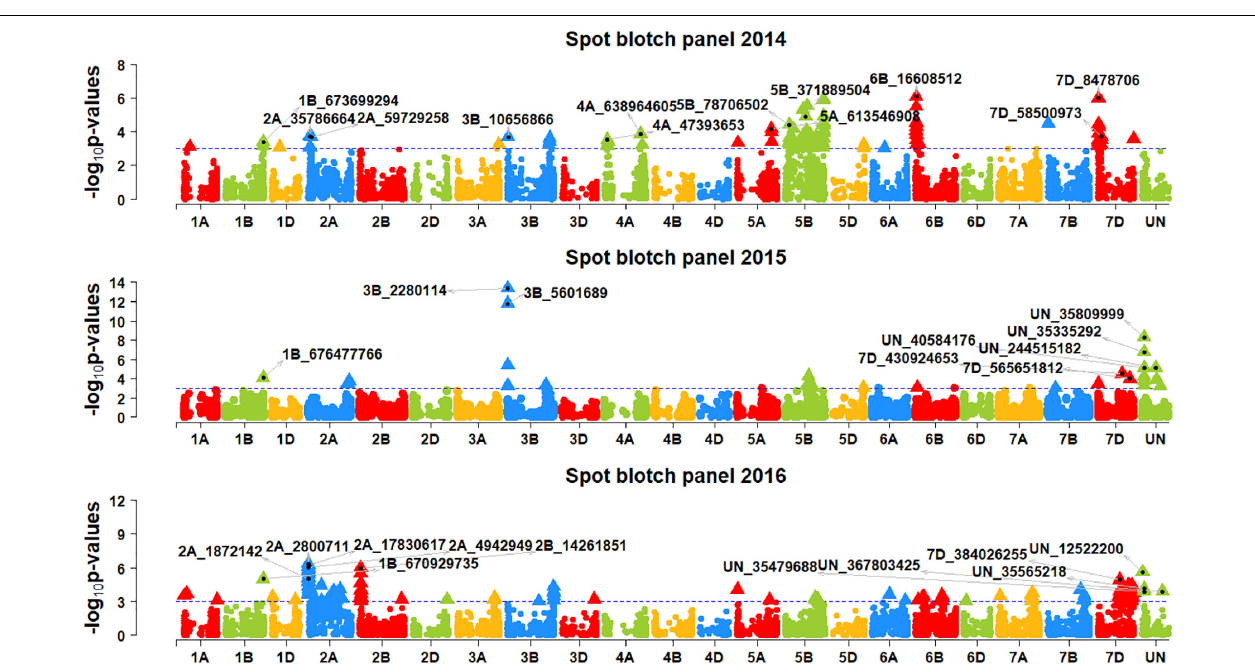
FIGURE 2 | Manhattan plots showing the marker –log 10 p -values and chromosomal positions obtained from genome-wide association mapping for spot blotch in panels 2014, 2015 and 2016. The blue line indicates the p -value threshold of 0.001 and selected markers that were either very significantly associated with spot blotch or associated in more than one panel are